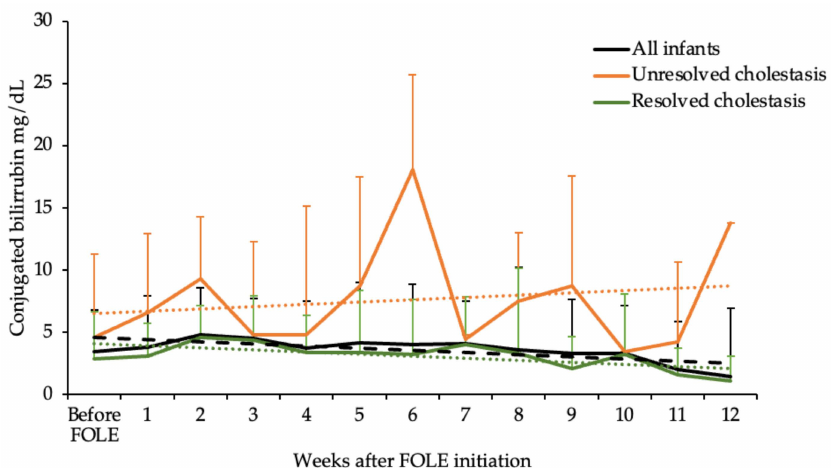
Figure 1. The trends of resolution for the plasma conjugated bilirubin following initiation of FOLE in all infants and separately for neonates that had cholestasis resolved versus unresolved. Data are shown as median and the positive value of the interquartile range (Q3–Q1). The discontinued line shows the decreasing of conjugated bilirubin by the linear model—black: all infants; orange: infants unresolved cholestasis; green: infants resolved